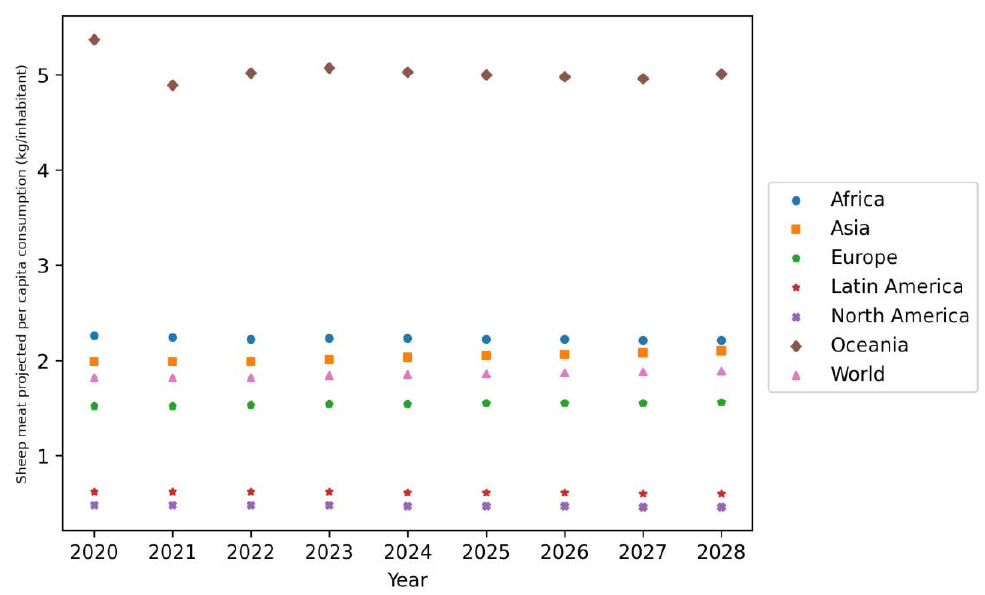
Figure 4. Sheep meat projected per capita consumption in the 2020–2029 period. Source: OECD (2023), Meat consumption (indicator). https://doi.org/10.1787/fa290fd0-en (accessed on 10 January 2023). Per capita consumption expressed in retail weight. Carcass weight to retail weight conversion factors of 0.7 for beef and veal, 0.78 for pork meat, and 0.88 for both sheep meat and poultry meat.